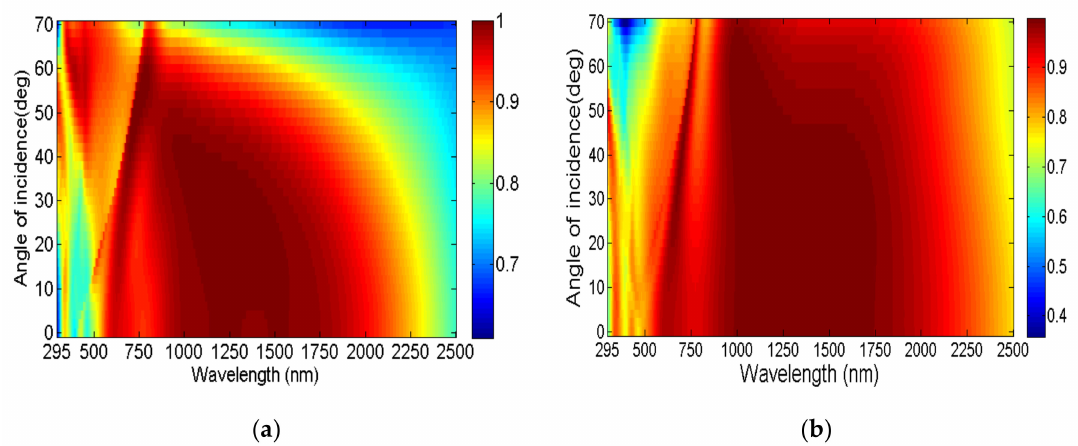
Figure 4. Absorption spectrum under oblique incidence at ( a ) TE polarization and ( b ) TM